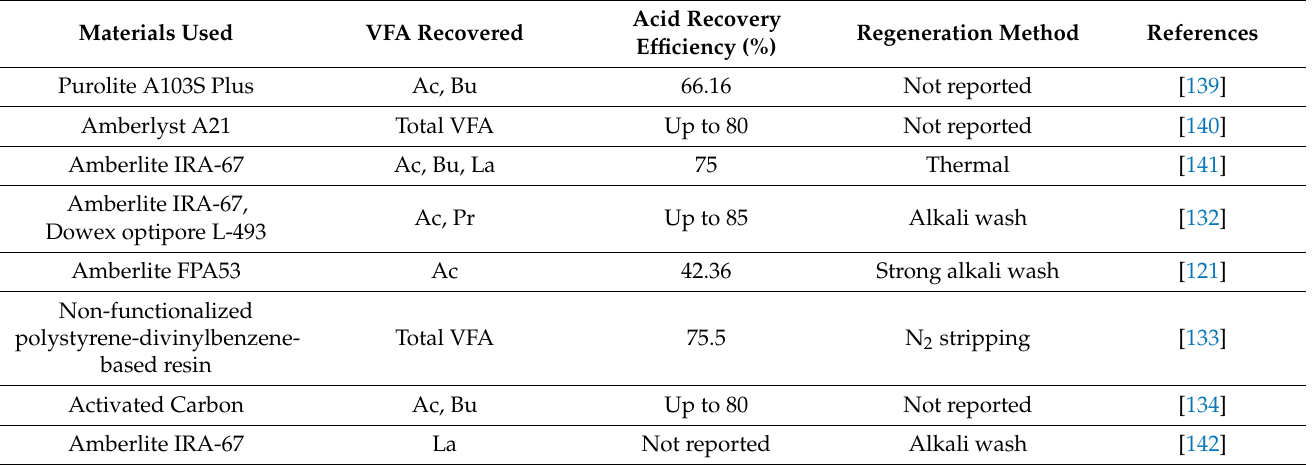
Table 3. Summary of recent works on VFA recovery using adsorption